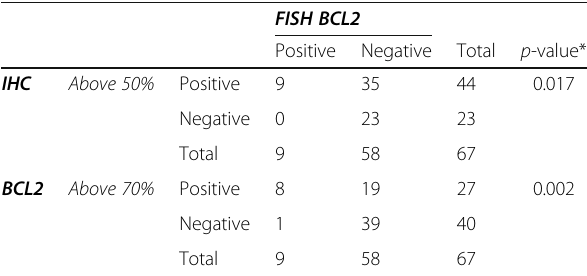
Table 1 Association between the positivity for BCL2 in the immunohistochemistry (IHC) for BCL2 and detection of BCL2 rearrangement by FISH: comparison between 50% cut-off